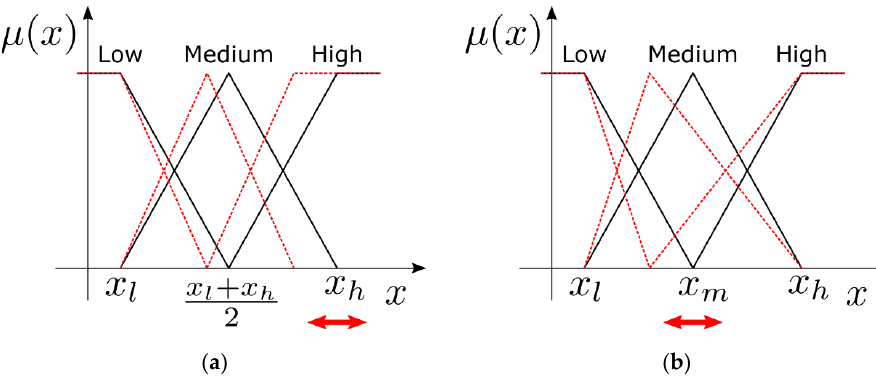
Figure 3. Deformations of the input membership function by changing the position of the maximum value, generating the family of the high radiation peak fuzzy controllers, (H)-FC ( a ) and the position of the medium value, generating the family of the medium radiation peak fuzzy controllers, (M)-FC ( b ).